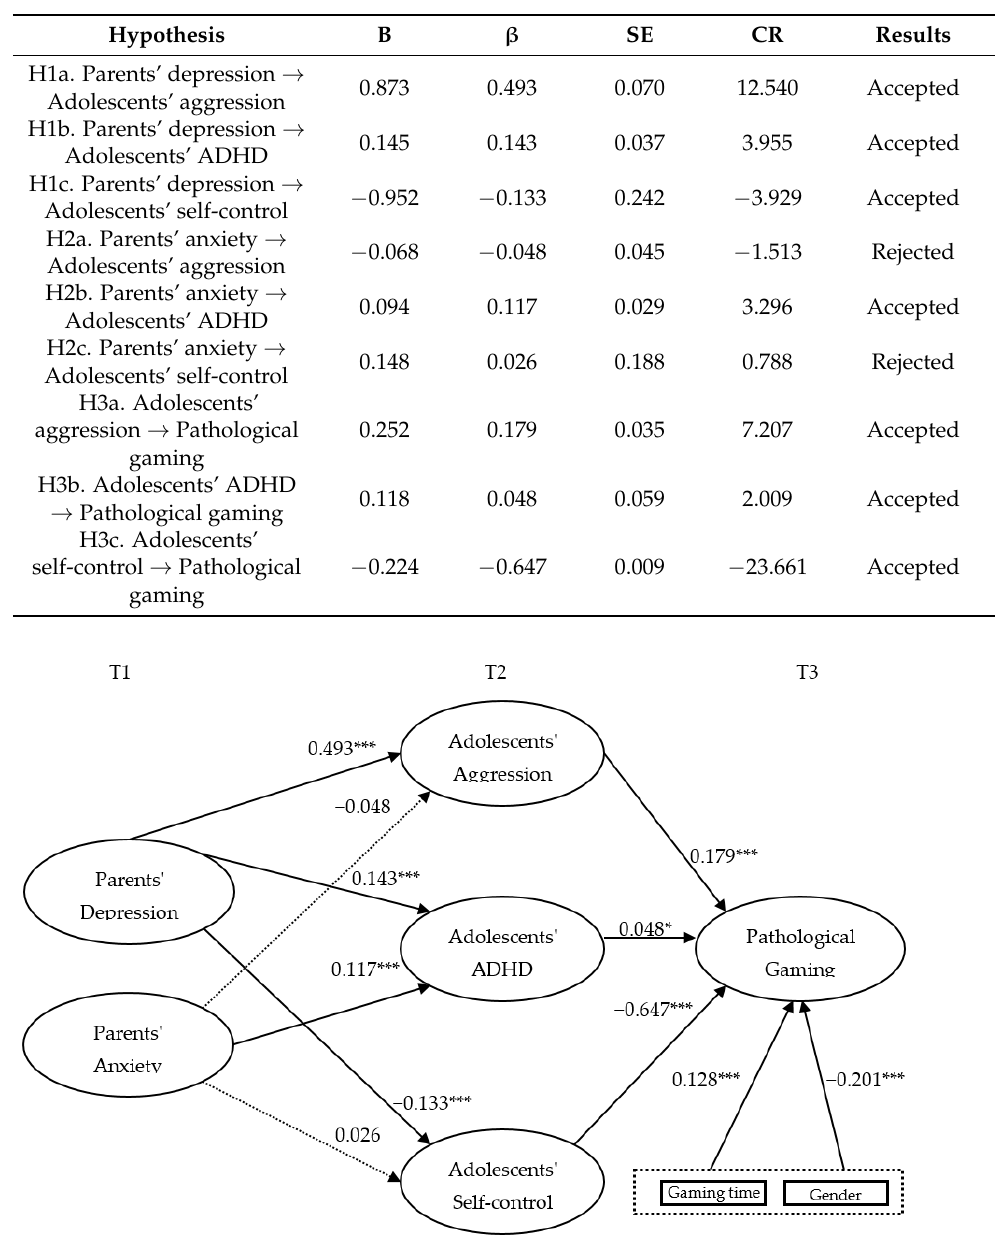
Table 3. Results of the hypothesis tests.